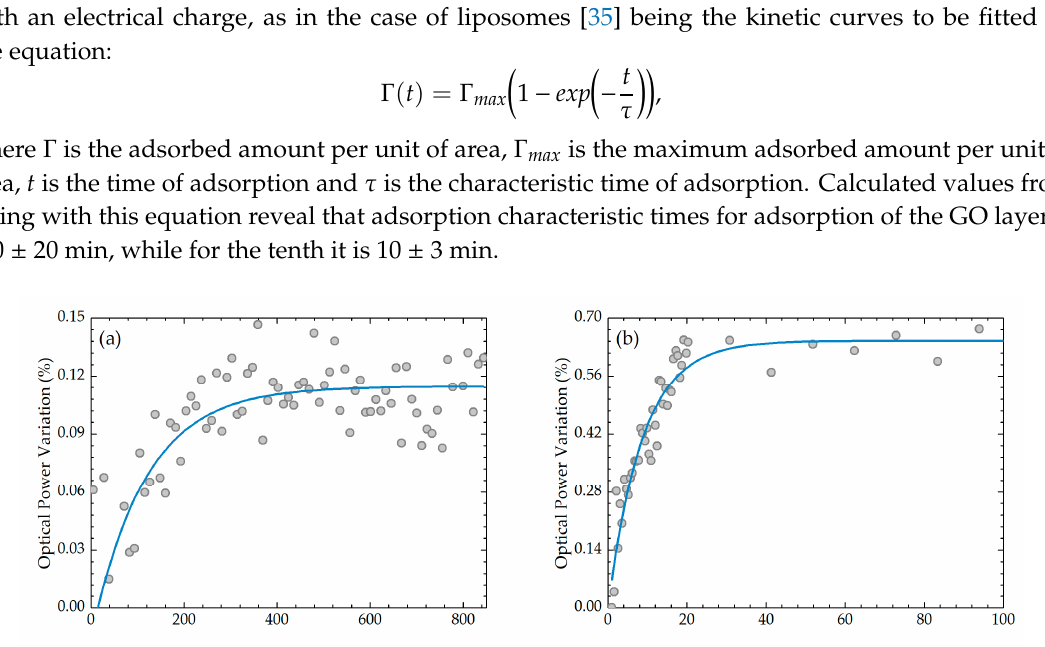
Figure 6. ( a ) Filtered signal corresponding to peak 2; ( b ) Wavelength shift of the peaks.